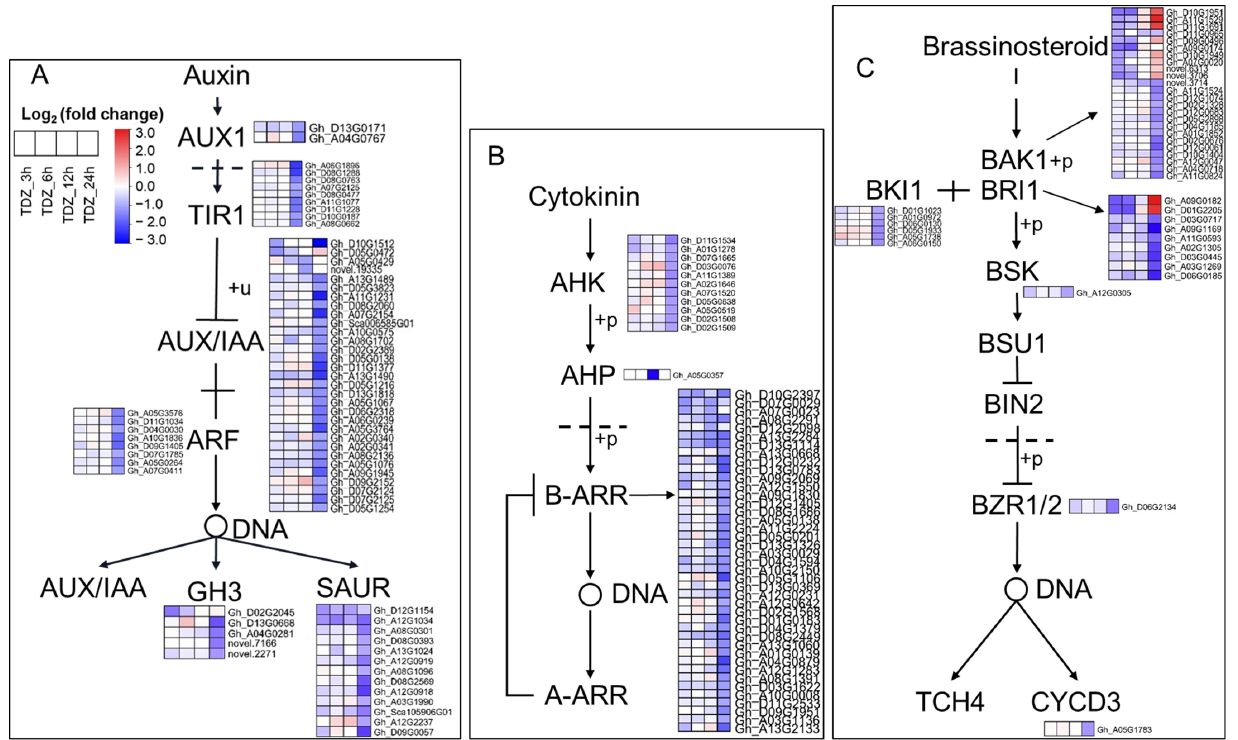
Figure 5. Genes with specific response to 300 mg/L thidiazuron (TDZ) compared with 0.6 mg/L ethephon (TDZ-SRGs) involved in plant hormone signal transduction. ( A ) Auxin. ( B ) Cytokinin. ( C ) Brassinosteroid.